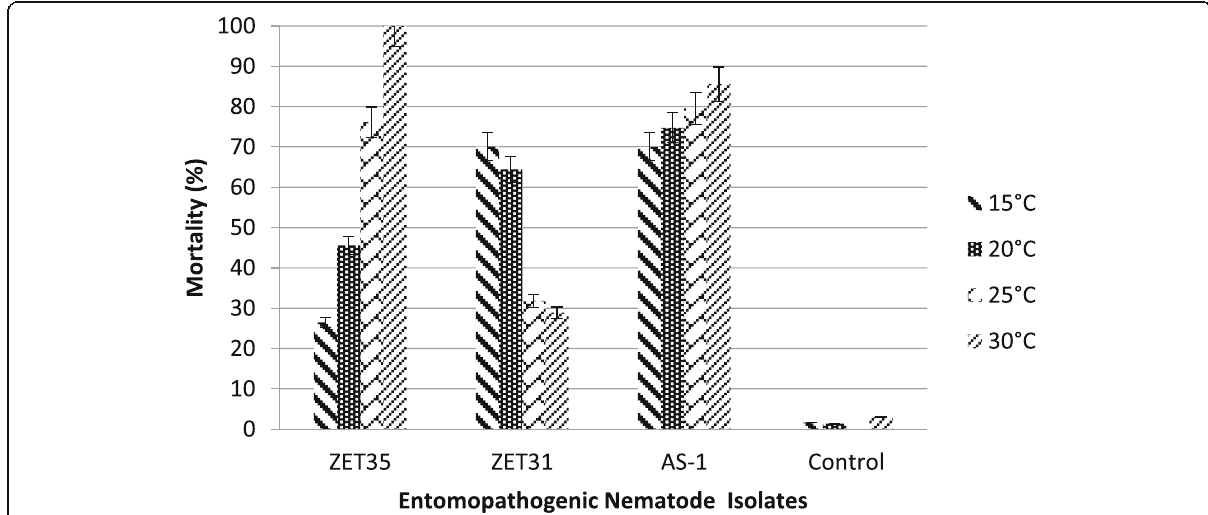
Fig. 3 Mean mortality rate of three native strains on pre-pupae of A. alni treated at a concentration of 1000 IJs/ml at four tested temperatures